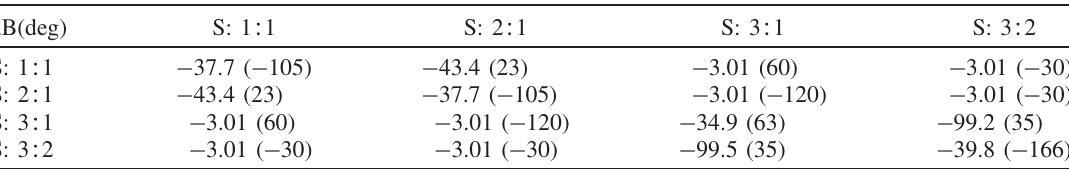
TABLE I. Scattering matrix of rf polarizer from